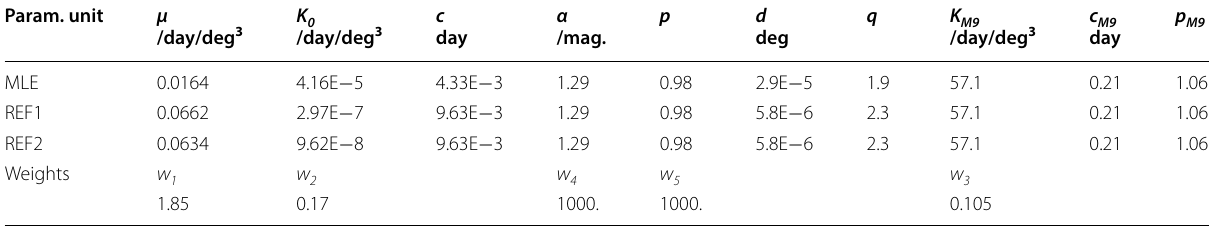
Table 1 Maximum likelihood estimates and reference parameters of the models Param.